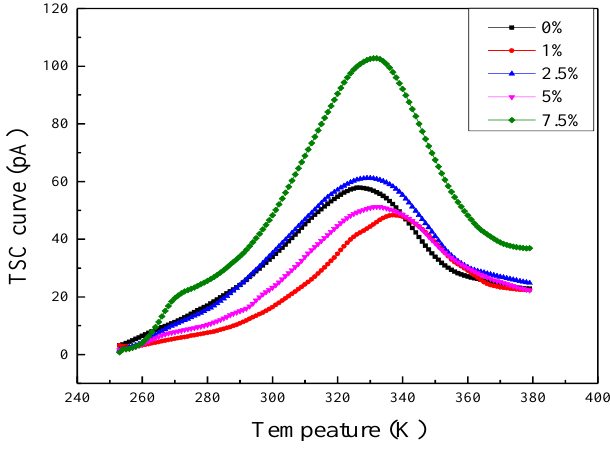
Figure 7. Thermally simulated current (TSC) spectra of nanocomposite pressboards.